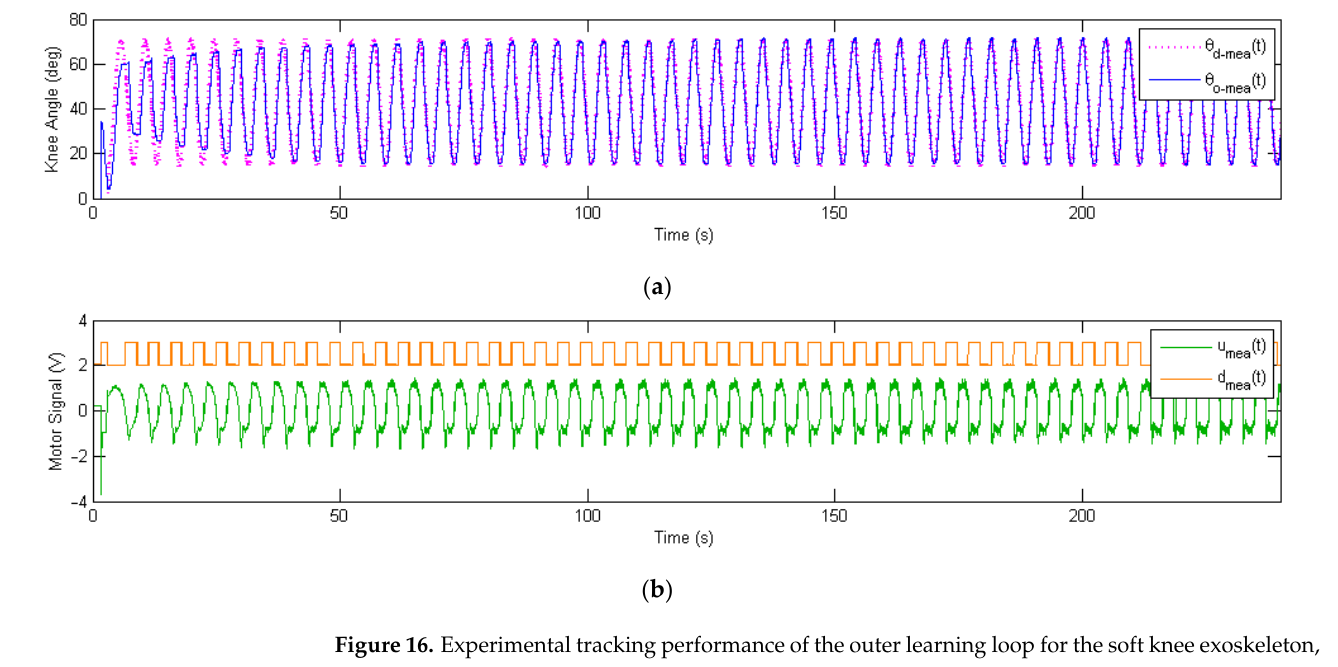
Figure 16. Experimental tracking performance of the outer learning loop for the soft knee exoskeleton, showing a total of 52 repetitions in the time domain. The P-type learning gain is 𝜑 = 0.25 , and the phase-lead compensation level is 𝛾 = 10 . ( a ) Measured sinusoidal response of the soft knee exoskeleton, with the desired knee angle 𝜃 𝑑−𝑚𝑒𝑎 (𝑡) in magenta and output knee angle 𝜃 𝑂−𝑚𝑒𝑎 (𝑡) in blue. ( b ) Measured motor control signal, showing both the motor voltage signal 𝑢 𝑚𝑒𝑎 (𝑡) in green and the motor direction signal 𝑑 𝑚𝑒𝑎 (𝑡) in orange.